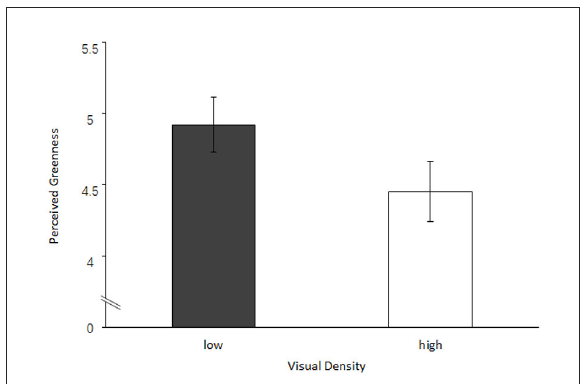
FIGURE1 The effect of visual density on perceived